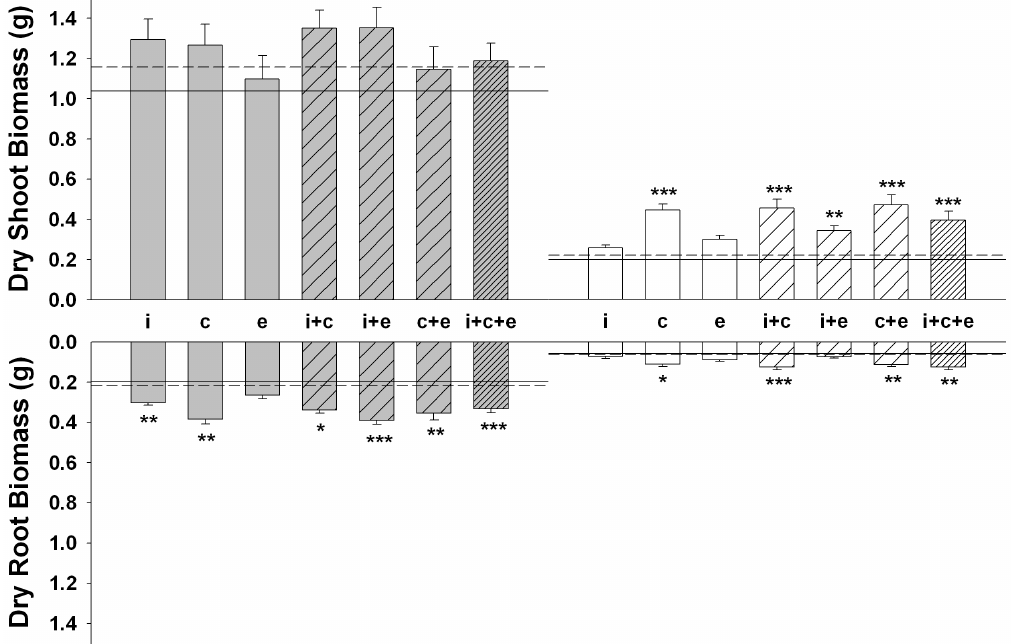
Figure 1. Effect of different AMF assemblages and R.solani on the dry shoot and root biomass of L.vulgare . Each grey and white bar represents the treatment mean 6 1 SE either in absence or presence of R. solani , respectively. Open, lighter and heavier diagonal patterns correspond to: single (i.e., i – R. intraradices /c – R. clarus /e - C. etunicatum ), dual or tri isolate assemblages, respectively. Horizontal solid and dashed lines correspond to the control mean 6 1 SE, respectively. Those over the grey bars correspond to the negative control whereas those over the white bars correspond to the pathogen only (i.e., R. solani alone) control. Asterisks represent significant differences to the control calculated by Tukey’s HSD (* p , 0.05, ** p , 0.01, *** p , 0.001).